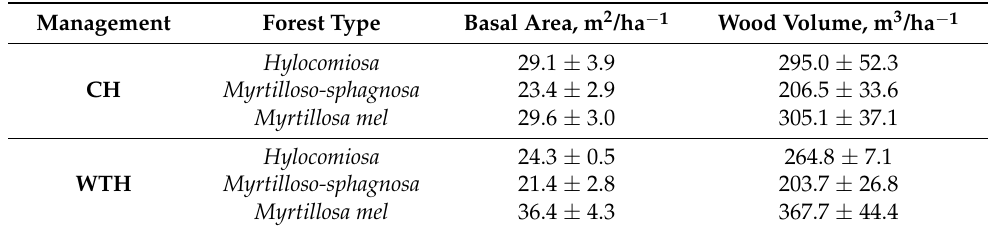
Table 3. The mean values of tree stand productivity for the analyzed forest types in the conventional (CH) and whole tree harvested (WTH)